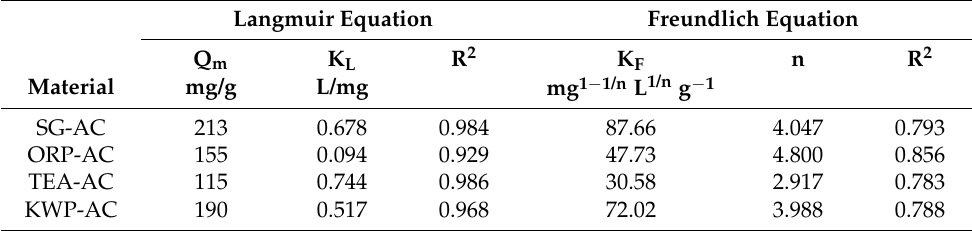
Figure 10. Isotherms of all AC samples at 25 °C. Table 3. Equilibrium parameters for the adsorption of PRM onto AC samples. Langmuir